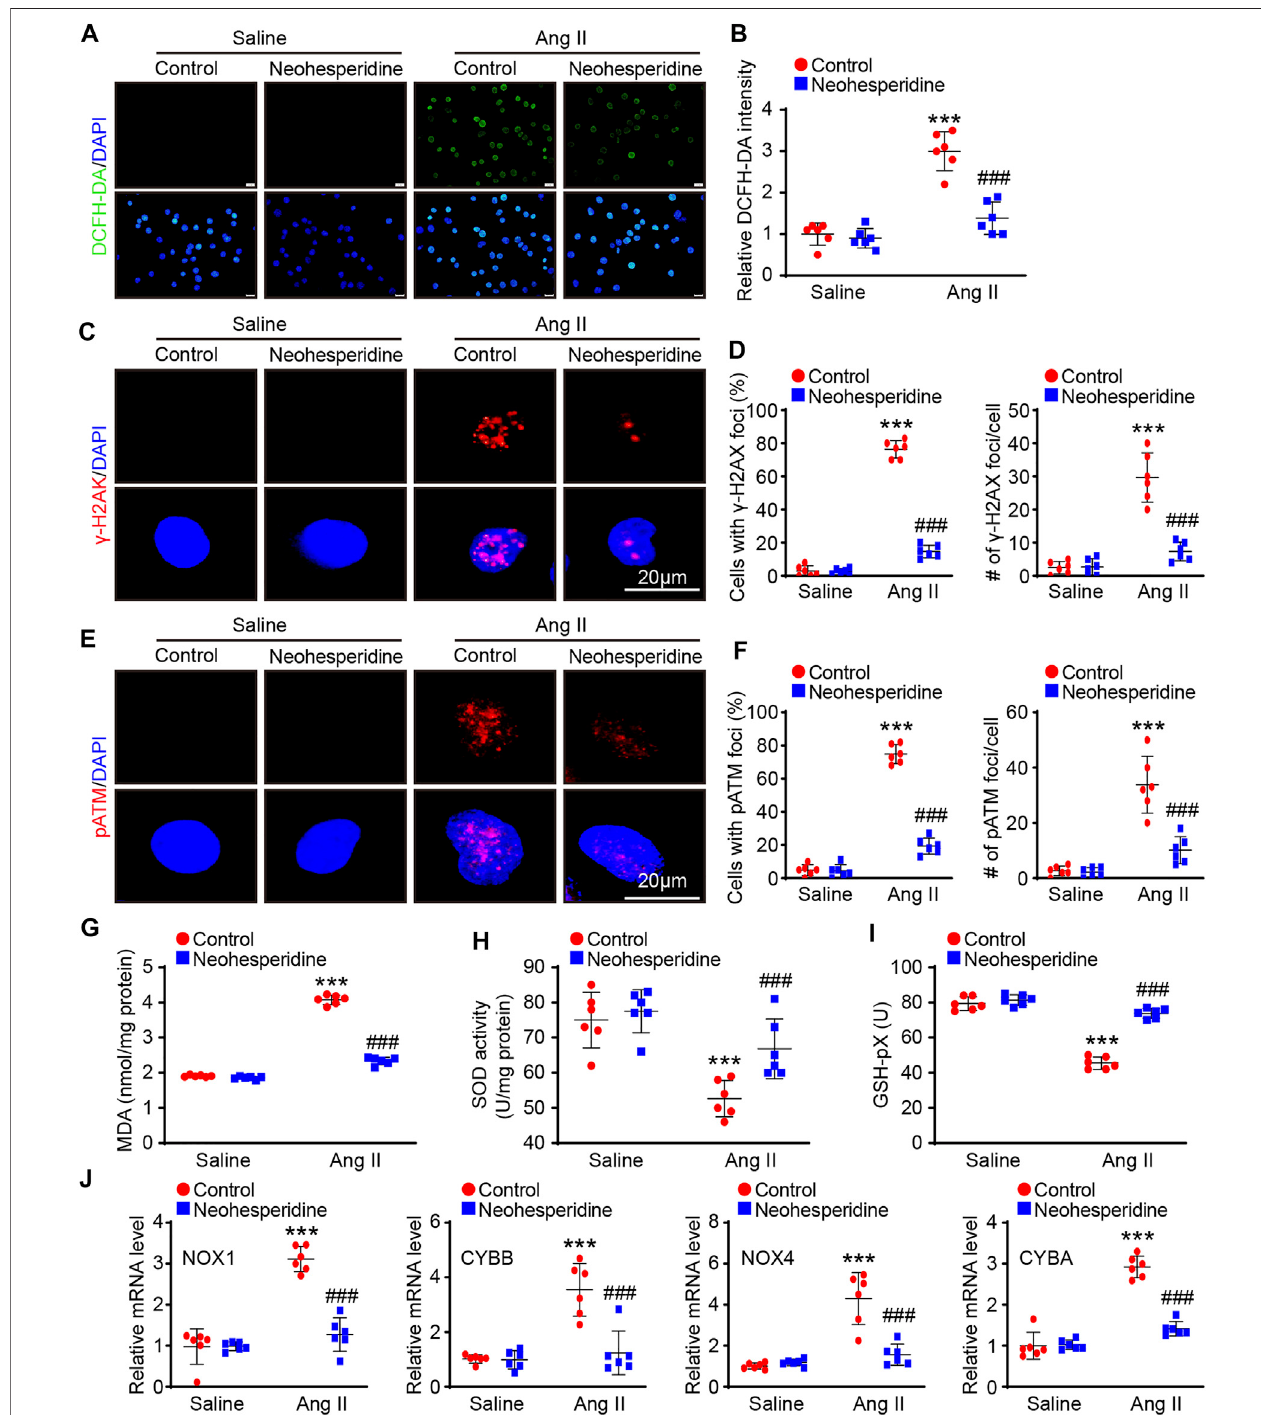
FIGURE5| Neohesperidin inhibitsAng II-induced HUVECsROSandDNADamage.Aftercellsweretreated withNeohesperidin was(20 μ m) for 24 h, Ang II (2 μ m) were added into cells for 24 h. (A) Representative images of DCFH-DA staining from each group (Bar = 20 μ m); (B) Histogram of the DCFH-DA intensity n = 6); (C) Representative images of γ -H2AX staining from each group (Bar = 20 μ m); (D) Histogram of the percentage of HUVCEs with positive γ -H2AX-positive nuclear foci (left, n = 6) and theaverage number of γ -H2AX fociin γ -H2AX-positive HUVECs (right, n = 6); (E) Representative images ofp-ATM staining from each group (Bar = 20 μ m); (F) Histogram of the percentage of HUVCEs with positive p-ATM -positive nuclear foci (left, n = 6) and the average number of p-ATM foci in p-ATM -positive HUVECs (right, n = 6); (G) Histogram of Malondialdehyde (MDA, n = 6); (H) Histogram of Superoxide dismutase (SOD, n = 6); (I) Histogram of Glutathione peroxidase (GSH-Px, n = 6); (J) qPCR analysis of NOX1, CYBB, NOX4, and CYBA mRNA levels from each group ( n = 6). Statistical analysis was performed with one-way ANOVA. *** p < 0.001, sham vs. Ang II; ### p < 0.001, Ang II vs. Ang II + Neohesperidin.